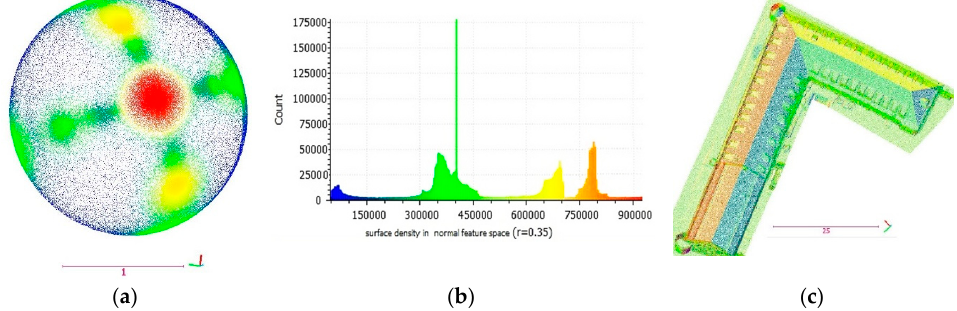
Figure 13. The normal vector space. ( a ) Directional cosines of normal vectors on the unit sphere. ( b ) Local surface density in feature space. ( c ) The labelled point cloud of the building.